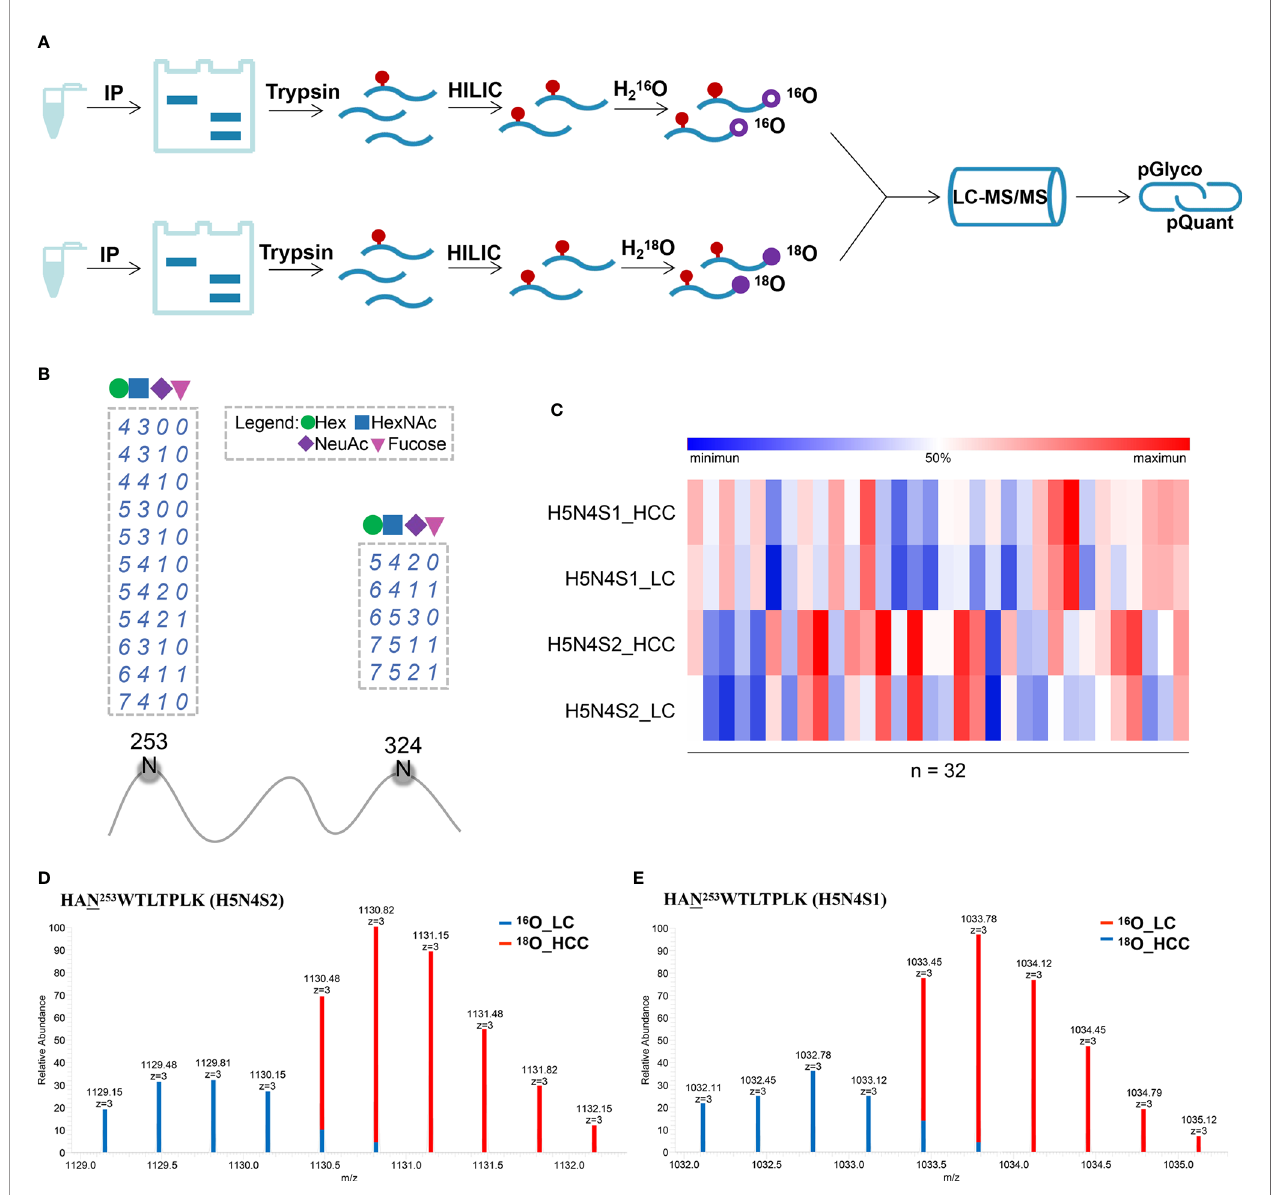
FIGURE 4 | (A) Work fl ow for labeling quanti fi cation of N-glycopeptides. (B) Visualization of all identi fi ed glycosylation sites (N) on PON1. The glycan compositions are expressed by the numbers of Hex, HexNAc, NeuAc, and Fucose (dashed box). (C) Heat map of the two differentially expressed intact glycopeptides in PON1 (site N253) between AFP-negative HCC and cirrhosis (LC, n = 32; HCC, n = 32). (D) MS 1 spectrum of HAN 253 WTLTPLK (H5N4S2). pQuant reported that the 18 O/ 16 O ratio was 2.82. (E) MS 1 spectrum of HAN 253 WTLTPLK (H5N4S1). pQuant reported that the 18 O/ 16 O ratio was